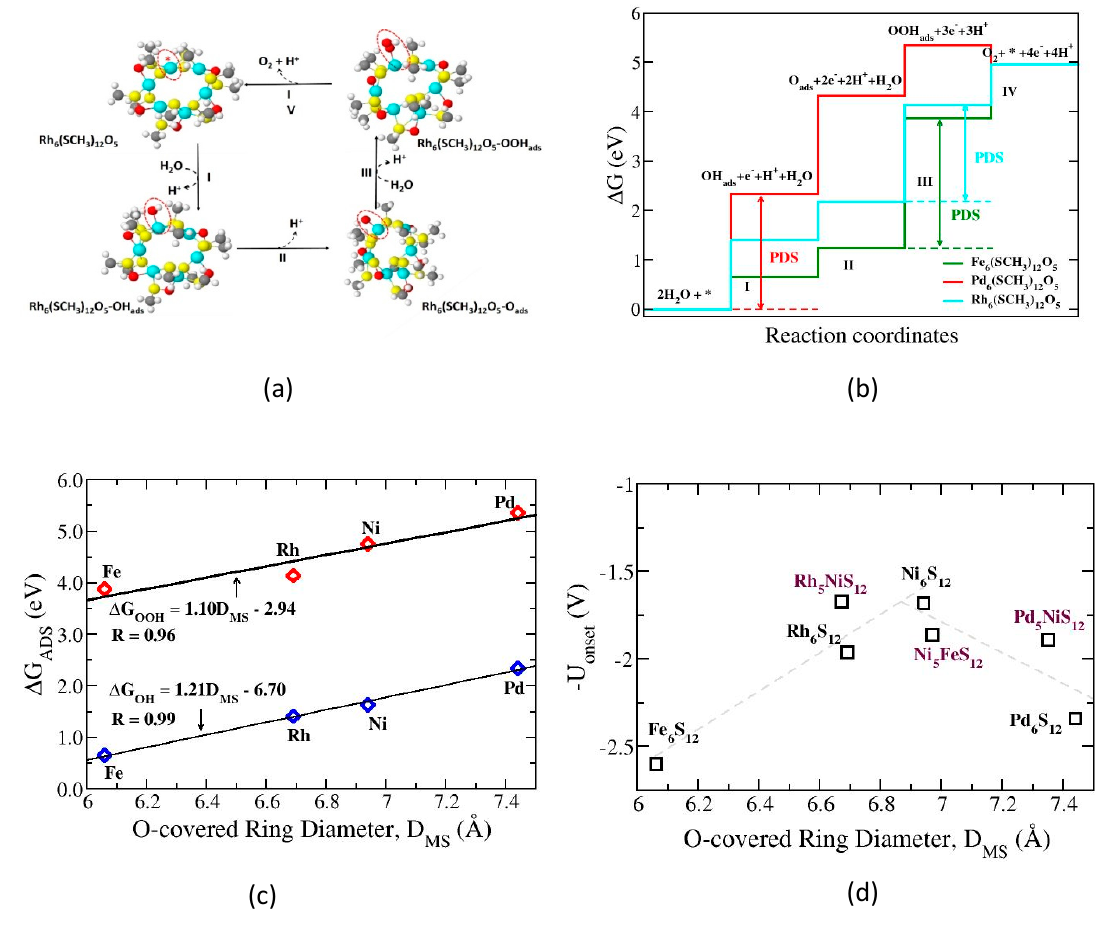
Figure 6. Schematic of the OER on M 6 (SCH 3 ) 12 O 5 (M = Fe, Pd, Rh) at room temperature and zero applied potential. ( a ) Predicted structures for all intermediates on Rh 6 (SCH 3 ) 12 O 5 . The adsorbed OER intermediates are highlighted with red dashed circle; the active site is an O-free metal atom marked with an asterisk. Cyan, yellow, red, grey, and white are Rh, S, O, and C, respectively. ( b ) Gibbs free energy of reactions; ( c ) Trends in ∆ G OH and ∆ G OOH described by the diameter of the O-covered M 6 S 12 ring, D MS Least-squares fits are provided together with the correlation coefficients. ( d ) Plot of the onset potential, U onset , versus the diameter of the O-covered M 6 S 12 (M = Fe, Rh, Ni, Pd) ring. Also included are the doped complexes (maroon color). The dashed lines are to guide the eyes. Adapted and reprinted with permission, from Ref. [45]. Copyright (2018) Elsevier B. V.